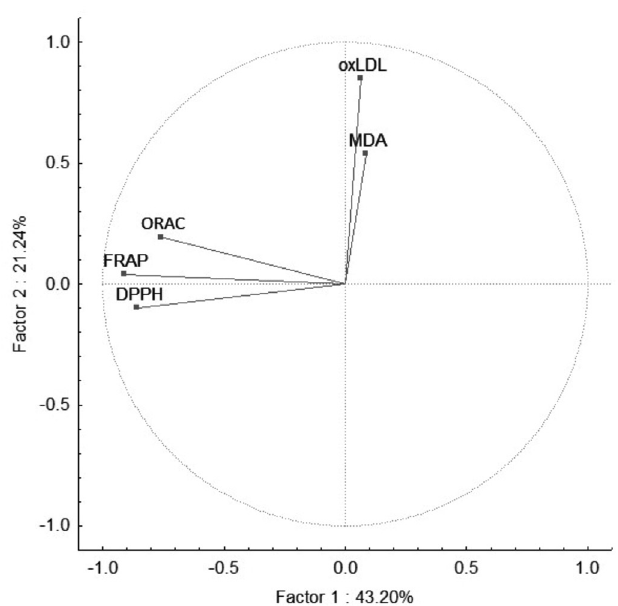
FIGURE 1- Projection of the variables (oxidative stress biomarkers) on the factor-plane (1 x 2).